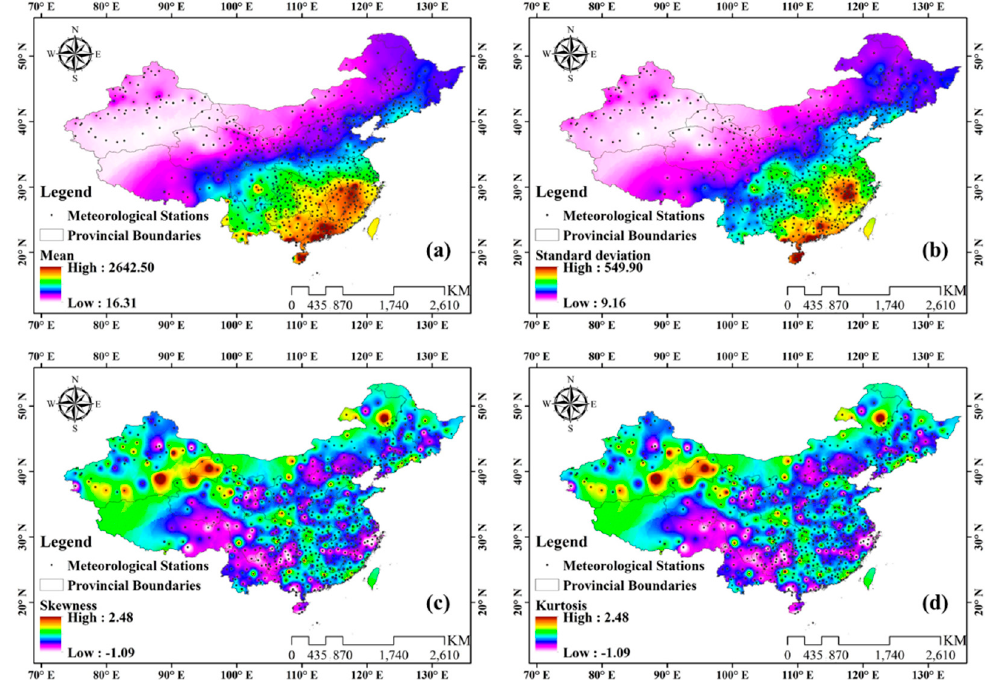
Figure 1. Spatial distribution of the observed average ( a ); standard deviation ( b ); skewness ( c ); and kurtosis ( d ) annual precipitation in China for the period 1971–2000.